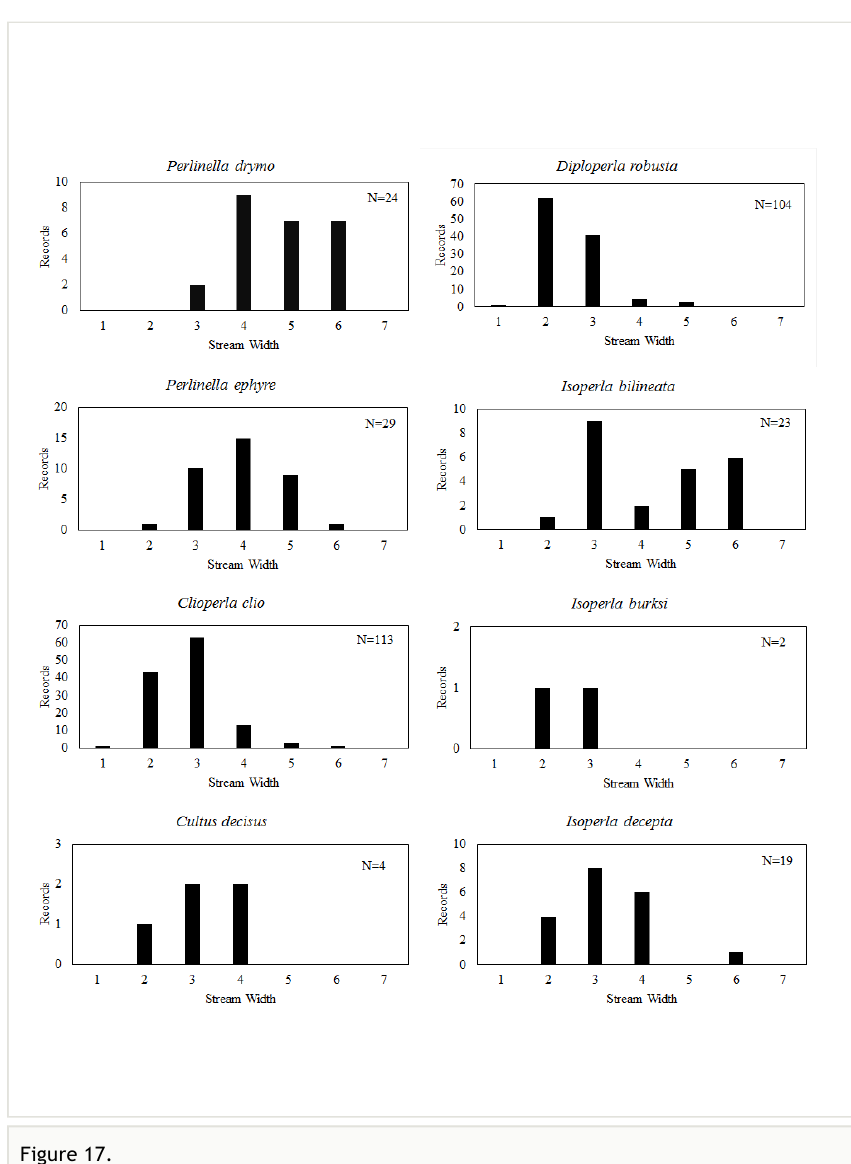
Figure 17. Stream width categories occupied by Perlidae and Perlodidae species in Ohio. Stream width categories: 1=seep, 2=1-2 m, 3=3-10 m, 4=11=30 m, 5=31-60 m, 6=>60 m, 7=Lake